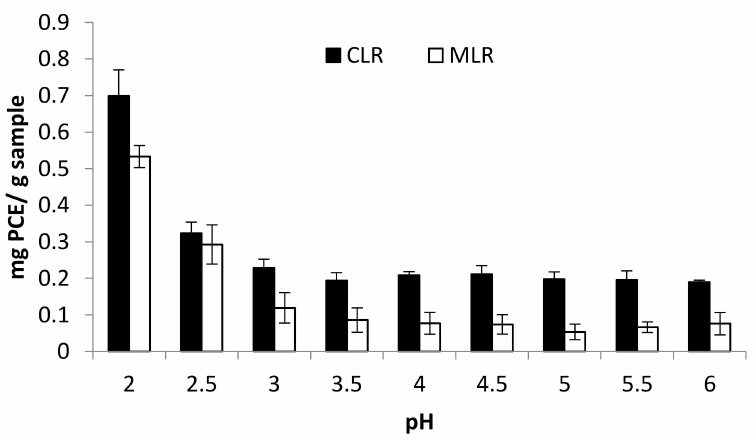
Figure 1. Effect of pH on total flavonoid content